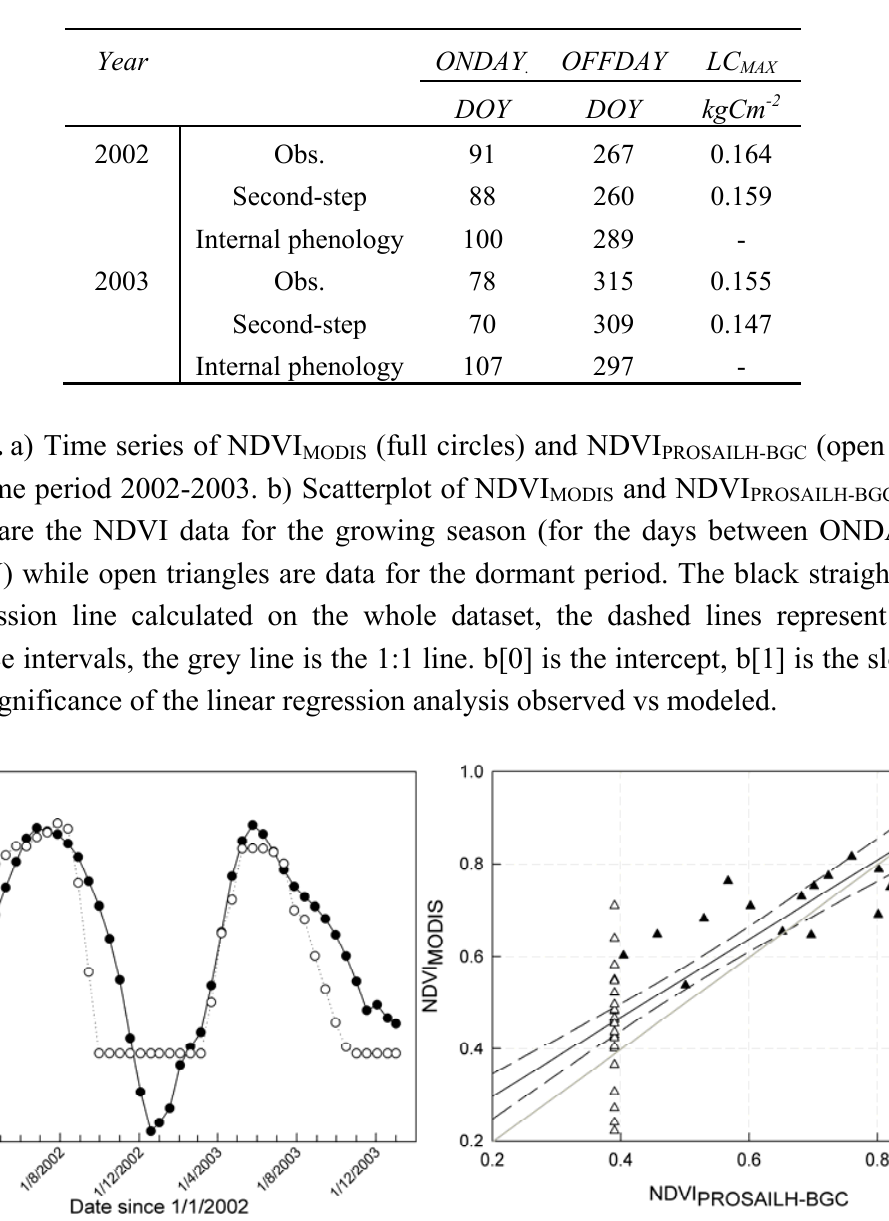
Table 3. Start (ONDAY) and end (OFFDAY) of growing season, maximum leaf carbon (LC ) observed and estimated with second-step model optimization. The ONDAY and MAX OFFDAY estimated with the internal phenological model (Internal phenology) were also reported. DOY is Day Of